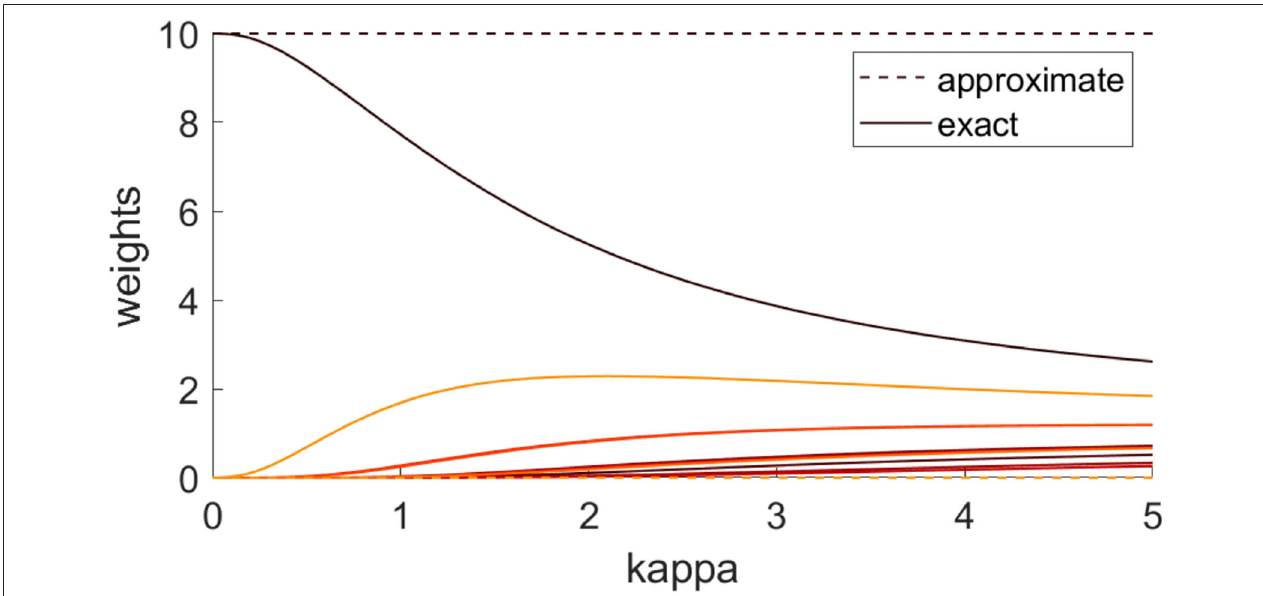
Figure 3 . For the exact weights, the particle uncertainty parameter κ is